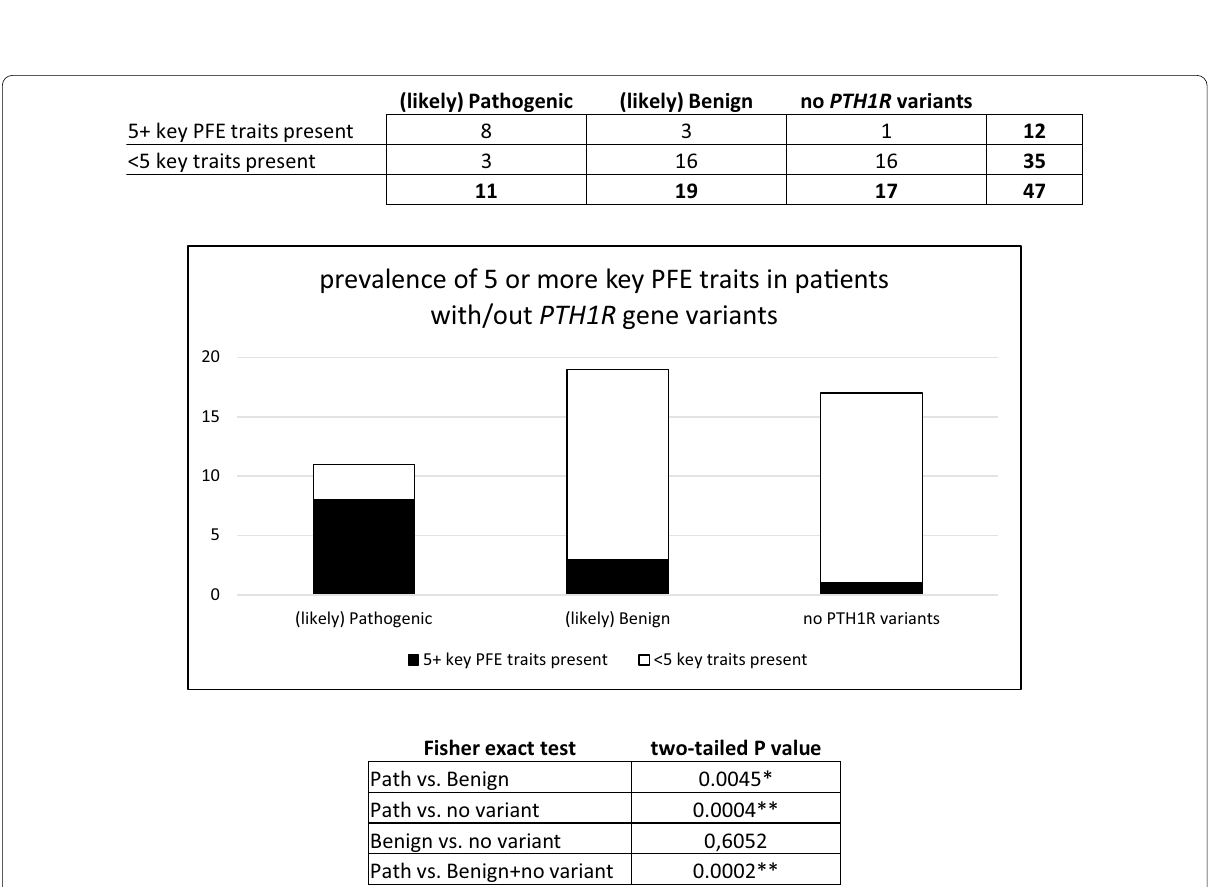
Fig. 6 Statistical analysis and significant association of 5 or more PFE key traits (hallmark signs) with (likely) pathogenic PTH1R